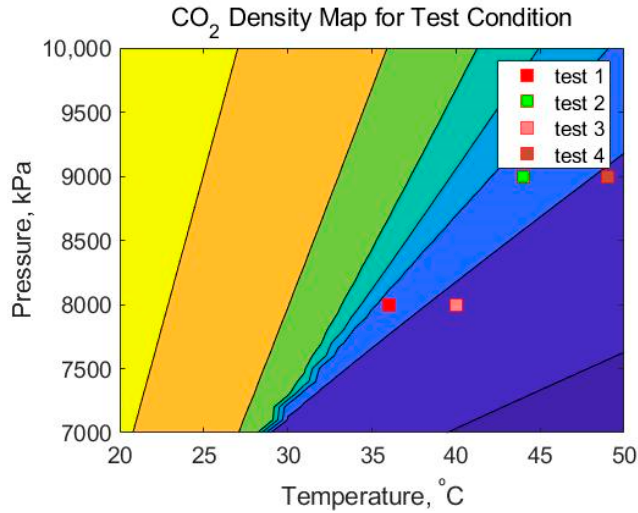
Figure 17. CO 2 density map for test condition.